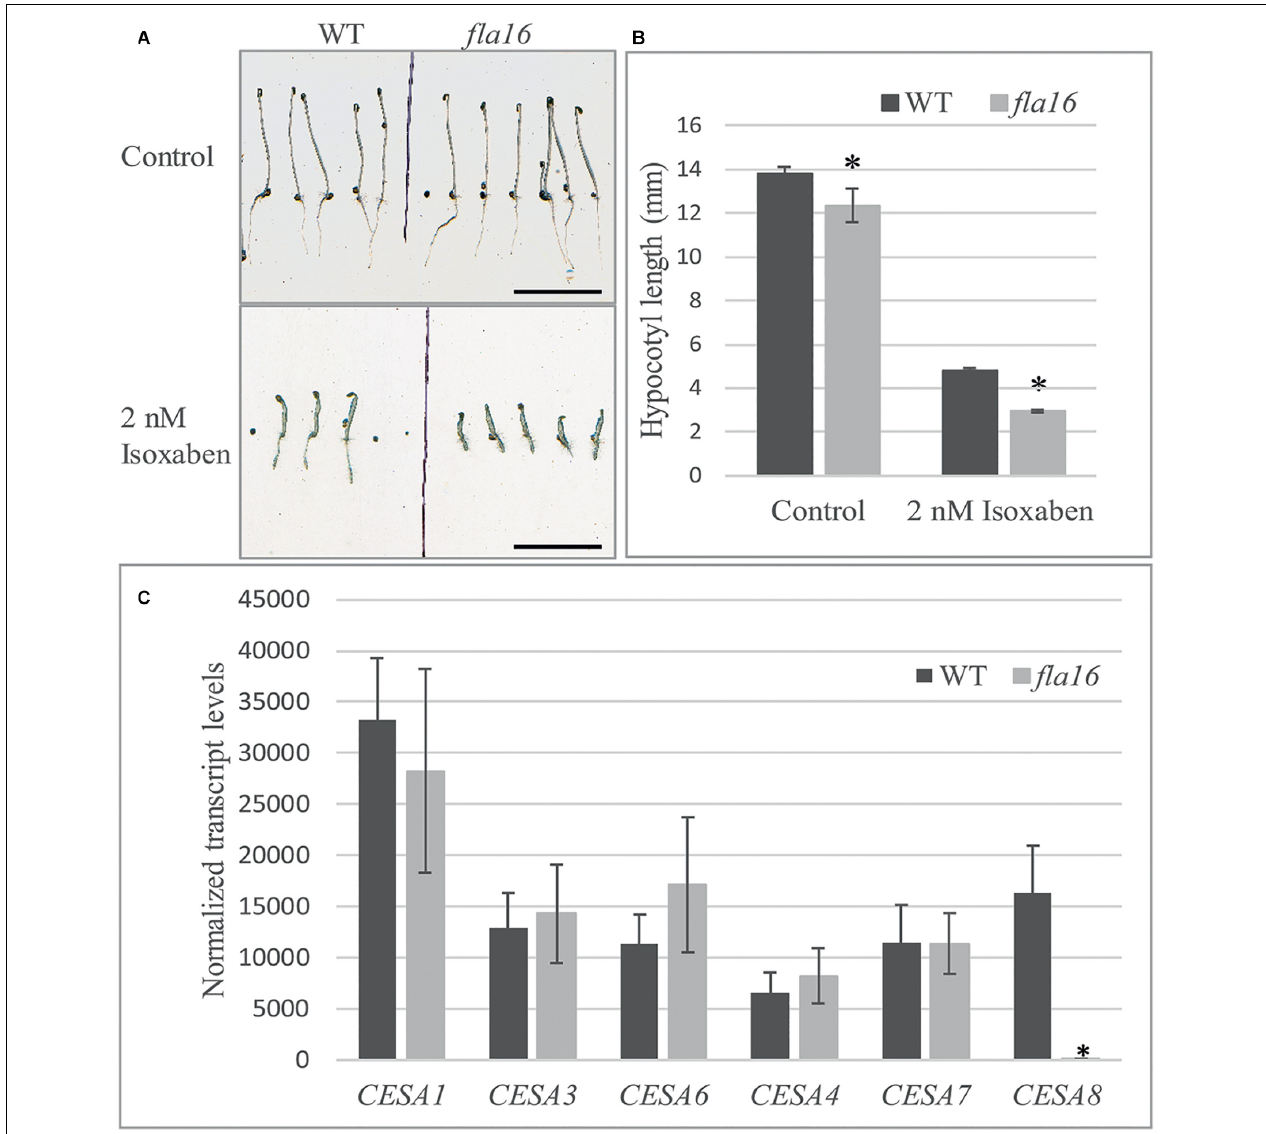
FIGURE 5 | Isoxaben treatment of dark grown Arabidopsis fla16 and WT seedlings and Q-PCR analysis of CESA transcript levels. Significantly reduced hypocotyl length is observed in fla16 seedlings on control plates and those treated with 2 nM isoxaben compared to WT (A,B) . N = 40–60, data represented as mean ± SE, * indicates statistically significant value, P < 0.05 using one-way ANOVA. (C) Q-PCR analyses of transcript levels of CESAs involved in primary ( 1 , 3 , and 6 ) and secondary ( 4 , 7 , and 8 ) wall biosynthesis shows CESA8 levels are significantly reduced in the basal stem segments of fla16 mutants compared to WT. Transcript levels were determined relative to DNA standards of known concentration and normalized with GAPDH and tubulin (Czechowski et al., 2005). N = 3 biological replicates, data represented as mean ± SE, * indicates statistically significant value p < 0.05 using one-way